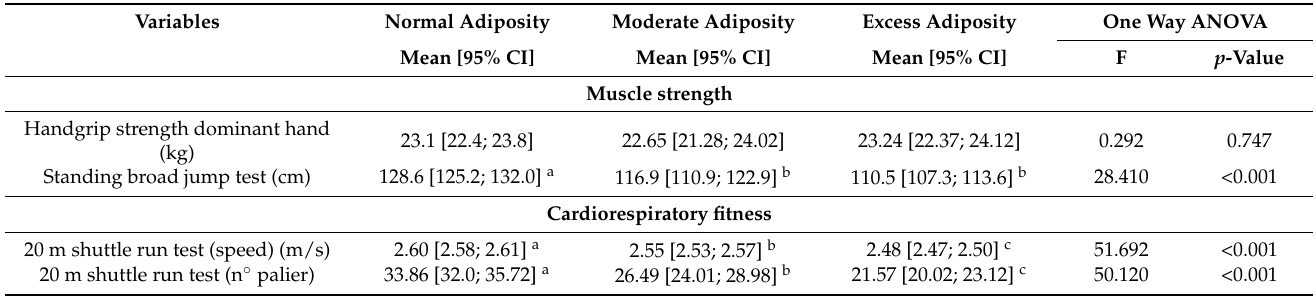
Table 3. Cardiorespiratory fitness and muscle strength according to adiposity.